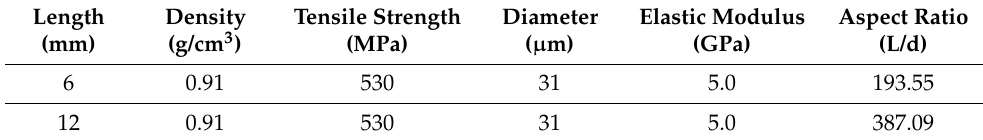
Table 2. Properties of the polypropylene fiber.